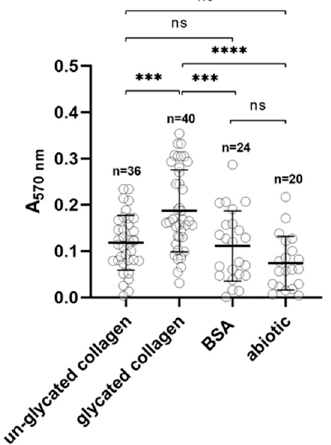
Figure 9. Biofilm formation. Ability of biofilm formation of P. gingivalis on glycated and un-glycated collagen-coated plates. Bovine serum albumin (BSA)-coated and un-coated (abiotic) plates were used as controls. *** p < 0.01; **** p < 0.001; ns, not significant; A, absorbance.